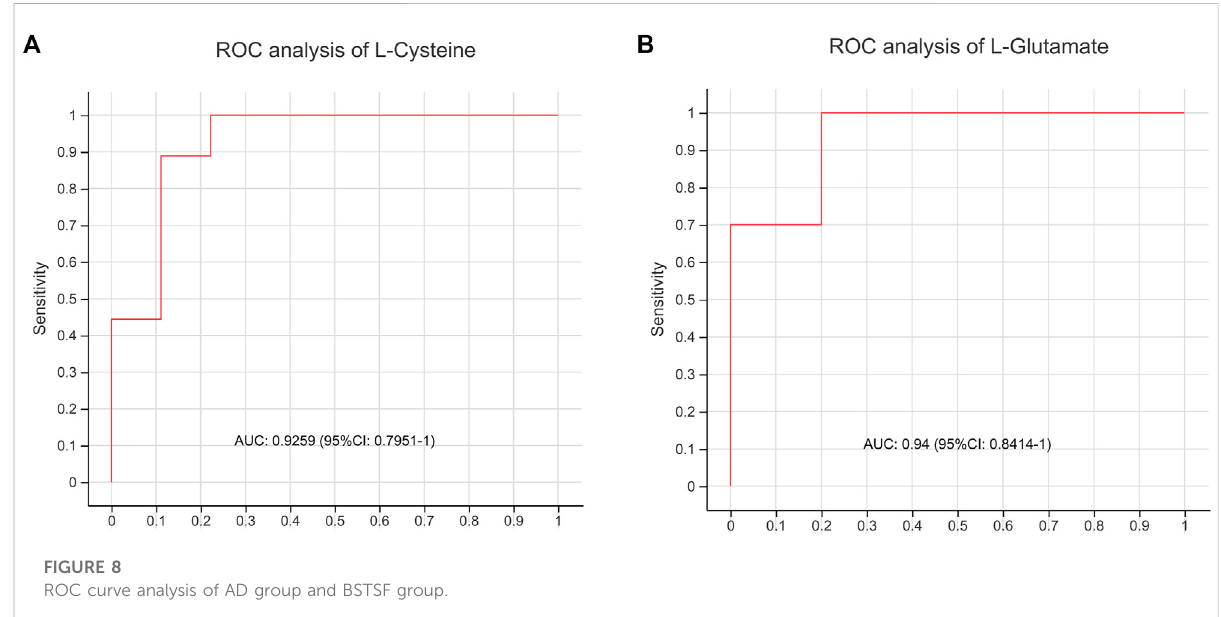
FIGURE 8 ROC curve analysis of AD group and BSTSF group.